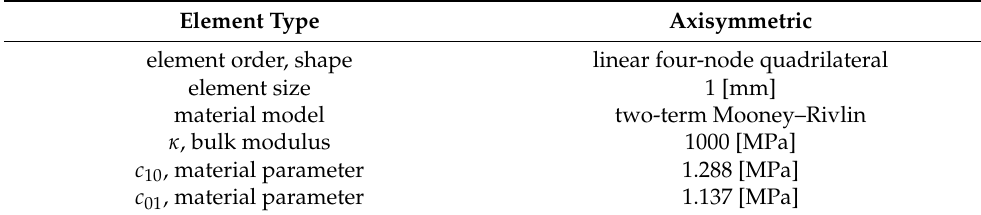
Figure 3. The working characteristics of the investigated rubber bumper with the optimum and initial shape. Table 1. Defined attributes for the finite element